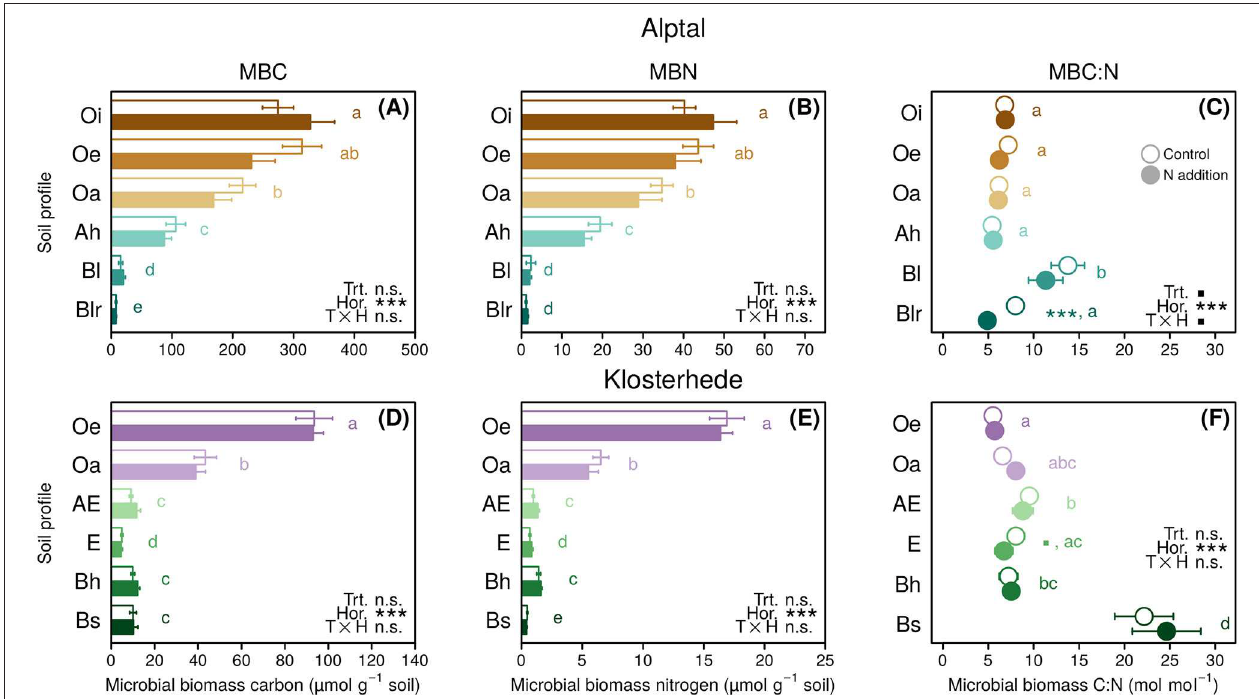
FIGURE 2 | The mean ( ± 1 SE, n = 4) of microbial biomass carbon (A,D) , microbial biomass nitrogen (B,E) , and microbial C:N ratios (C,F) in response to N addition along the topsoil profile (0–30cm) at Alptal (A–C) and Klosterhede (D–F) . Post-hoc differences between control and N addition treatment within soil horizon are indicated by symbols next to pairs of bars/circles ( (cid:4) P < 0.1; * P < 0.05; ** P < 0.01; *** P < 0.001). Lower-case letters indicate post-hoc differences between soil horizons across treatments. Means with no letter in common are significantly different (Tukey’s HSD, α =